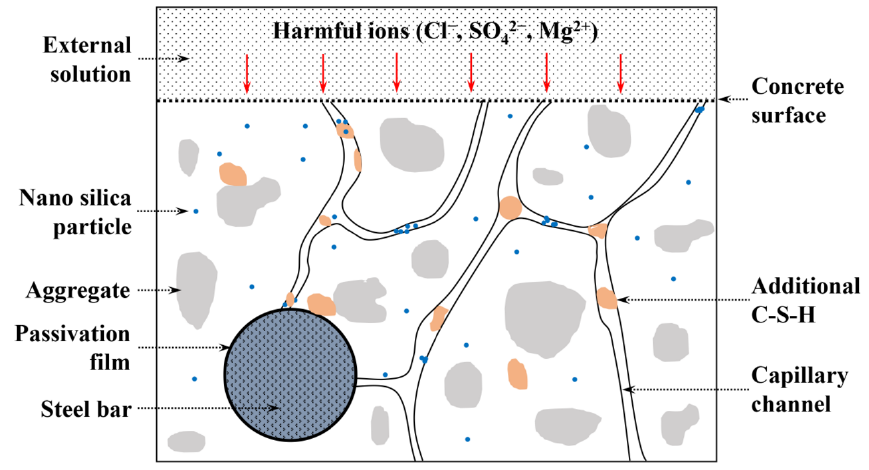
Figure 21. Schematic illustration of the enhancement mechanism of CNS.